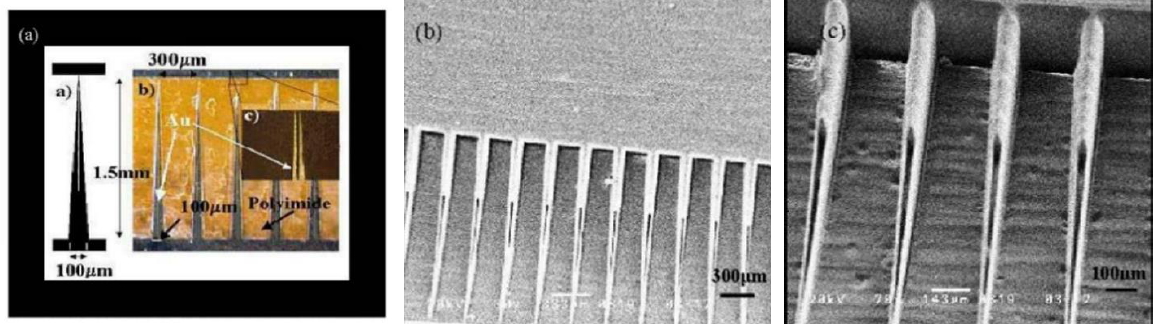
Figure 8. Fabrication results of PMMA in-plane MNA. ( a ) Pattern and size of mask. ( b ) In-plane solid MNA. ( c ) An enlarged image of ( b ).